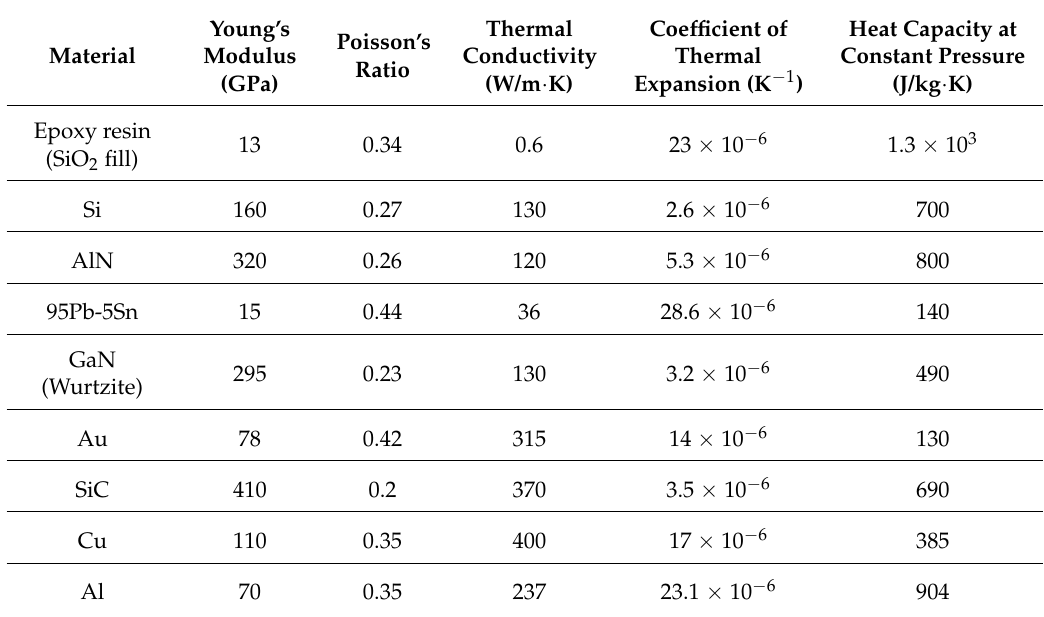
Table 3. Properties of the materials detected inside the GaN and SiC